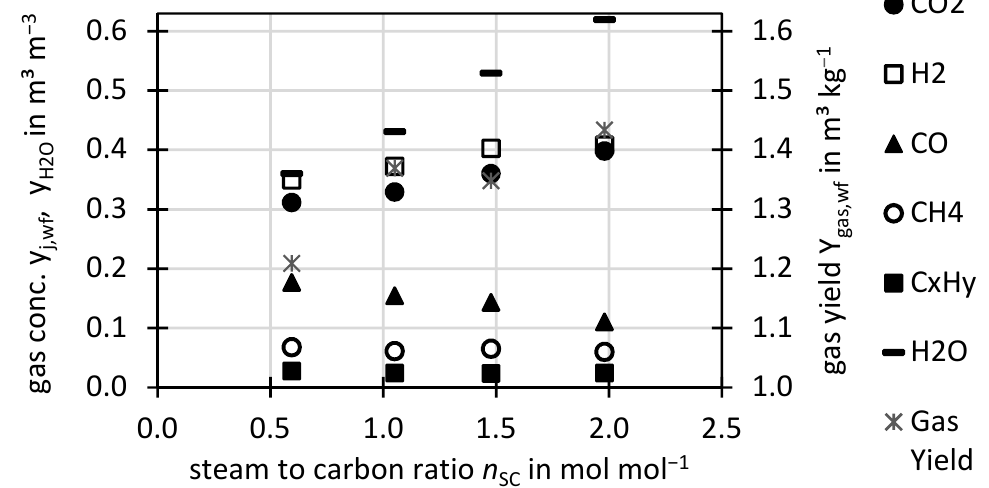
Figure 4. Permanent gas concentrations for different n SC in dry N 2 -free basis, for H 2 O wet N 2 -free